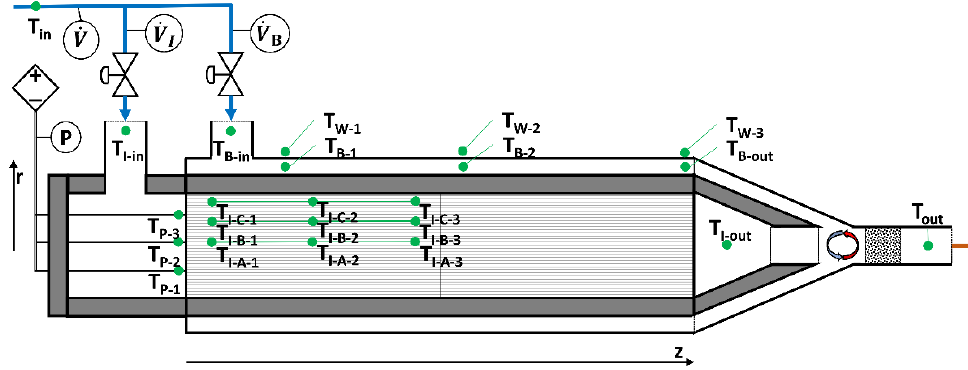
Figure 4. Central measuring points.